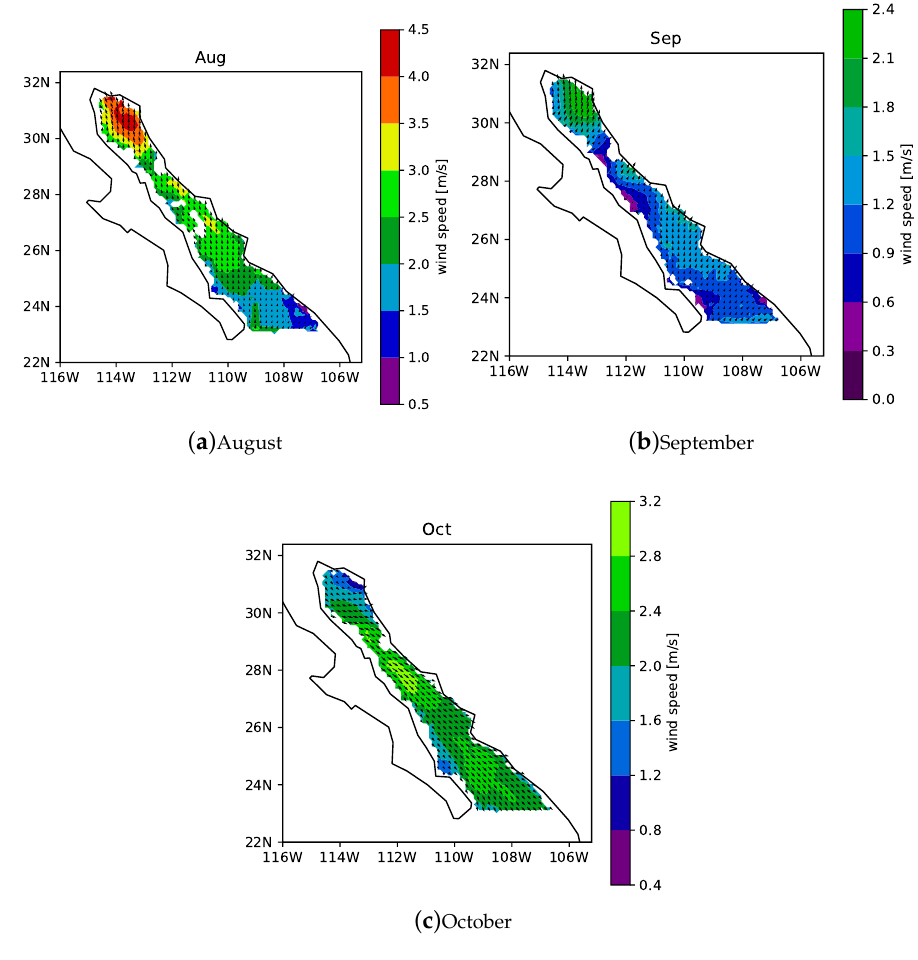
Figure 3. Wind field climatologies.